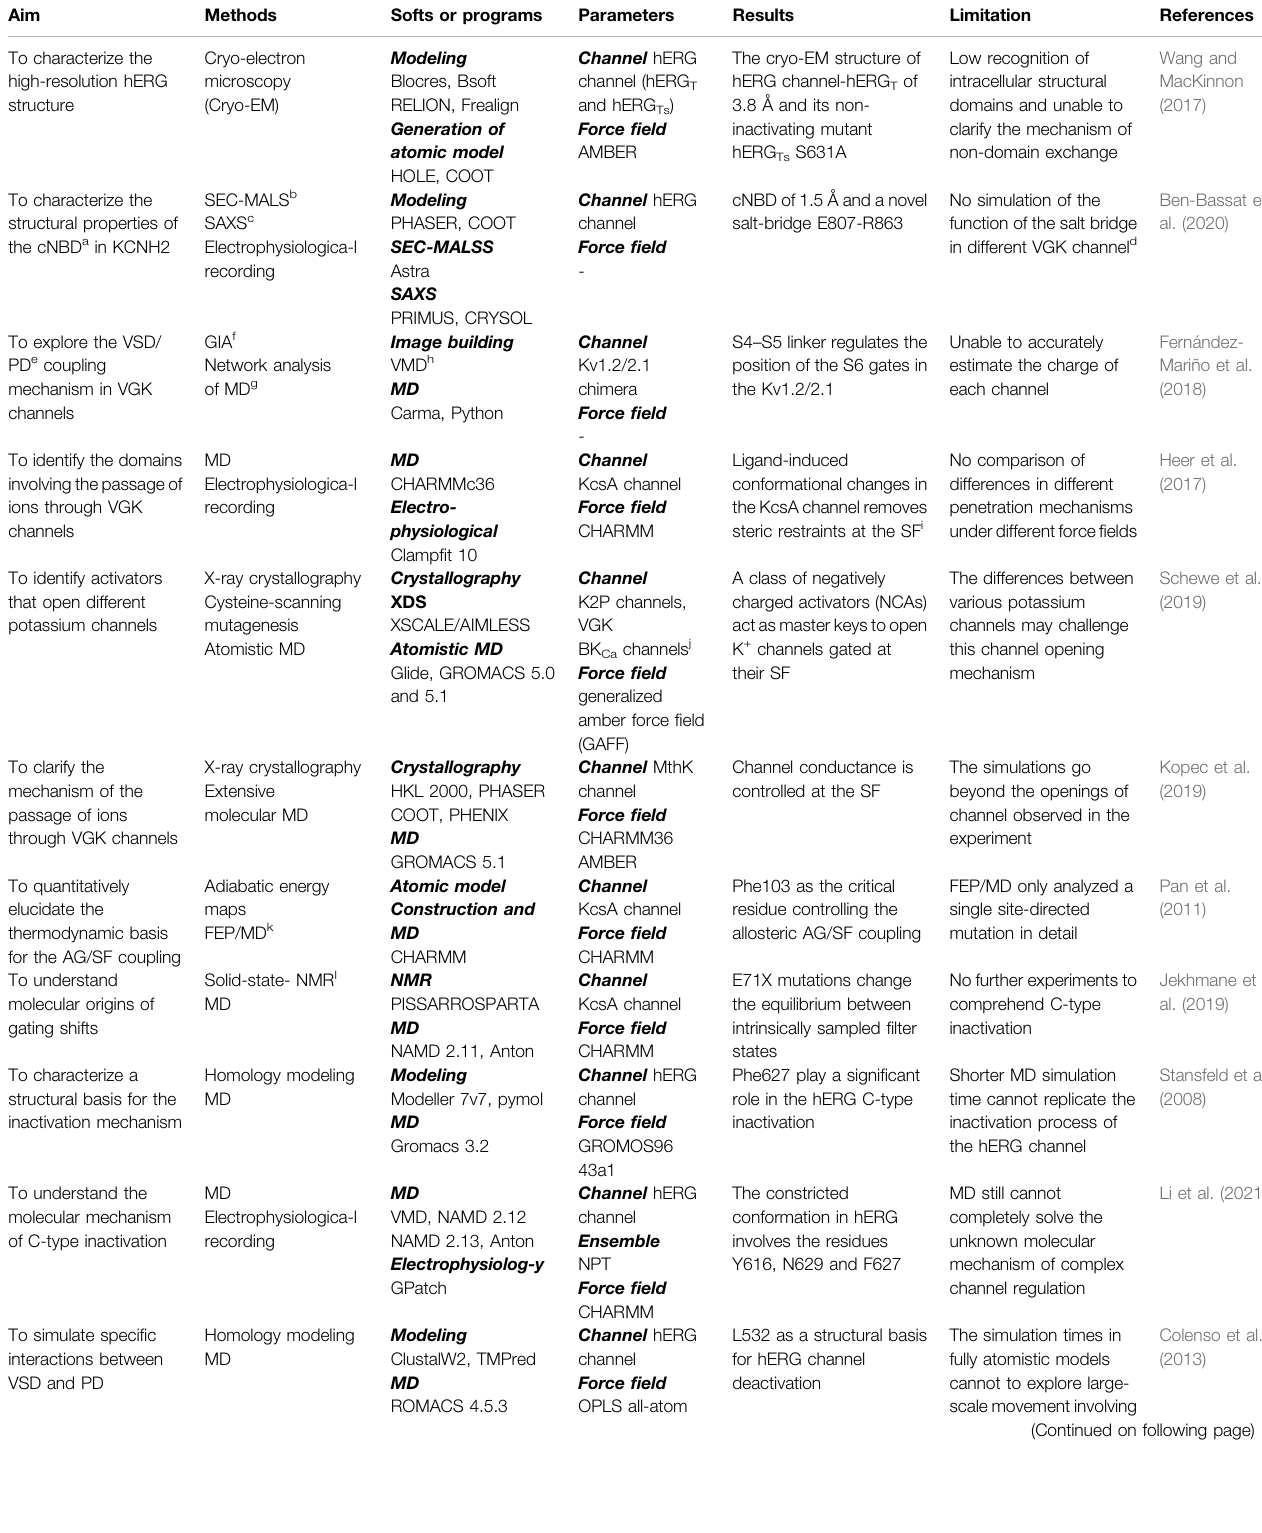
TABLE 1 | Summary of the main structure acquisition and molecular dynamics simulation results mentioned in the